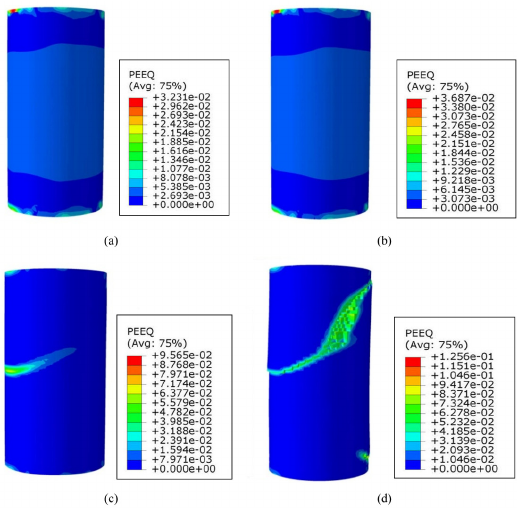
Figure 6. The equivalent strain map of 3mm samples in the deformation and fracture process at different strains, a) 3.81%, b) 3.82%, c) 3.83% and d) 3.84%.